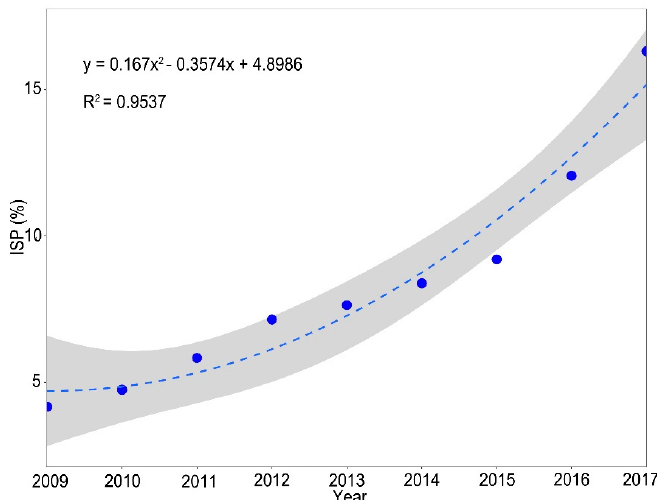
Figure 7. Change in impervious surface percentage from 2009 to 2017.